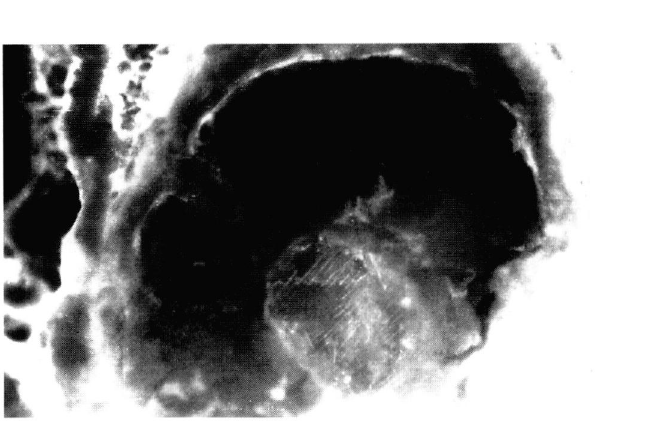
Fig. 2. — Detection by immunofluorescence of tyrosine phosphory lated proteins on the pseudo-segmentation of the cuticle in cryo- sections of T. spiralis larvae in parasitized